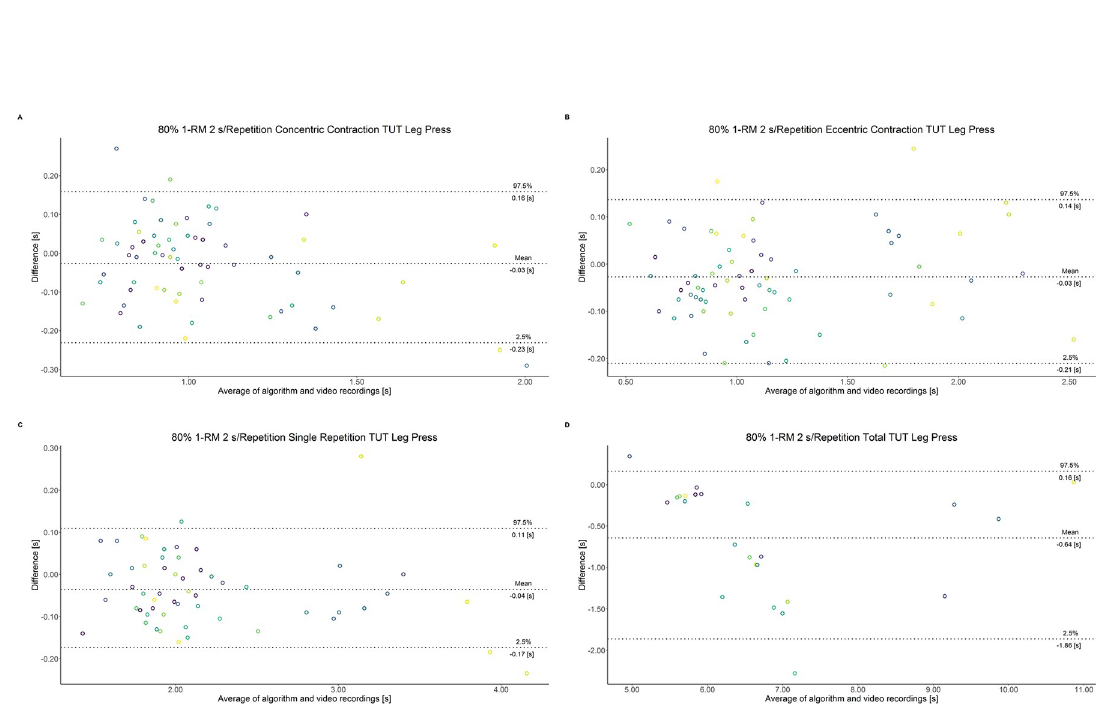
Fig 16. Bland-Altman plots of agreement between algorithmically accelerometer derived and video recordings derived contraction-specific phases of the leg press machine at 80% 1-RM with a velocity of 2 s per repetition. A: Concentric contraction phase. B: Eccentric contraction phase. C: Single repetition. D: Total time-under-tension.